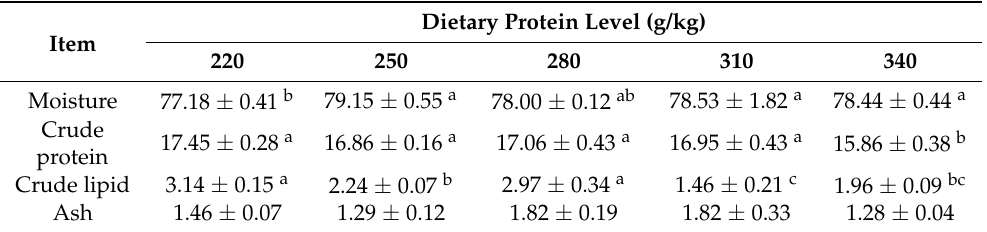
Table 4. Effects of different dietary protein levels on the proximate composition of Cyprinus carpio haematopterus (%, wet weight).